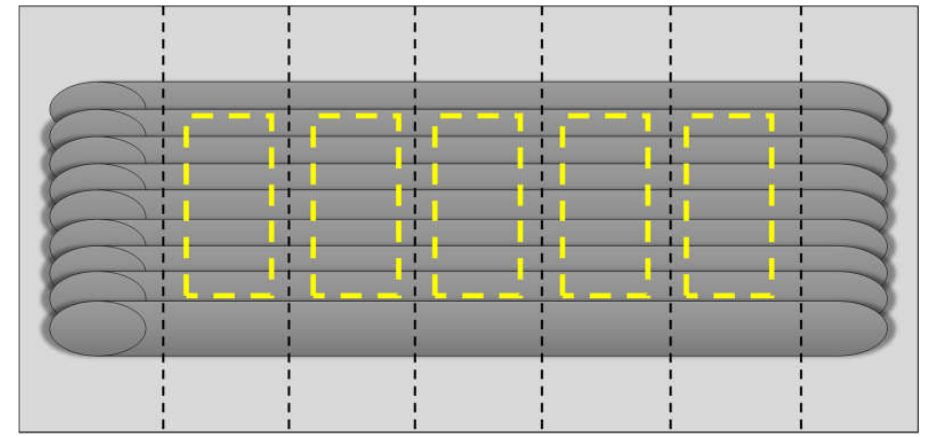
Figure 1. Layout of welded coating and cutting of samples for characterization of coatings.